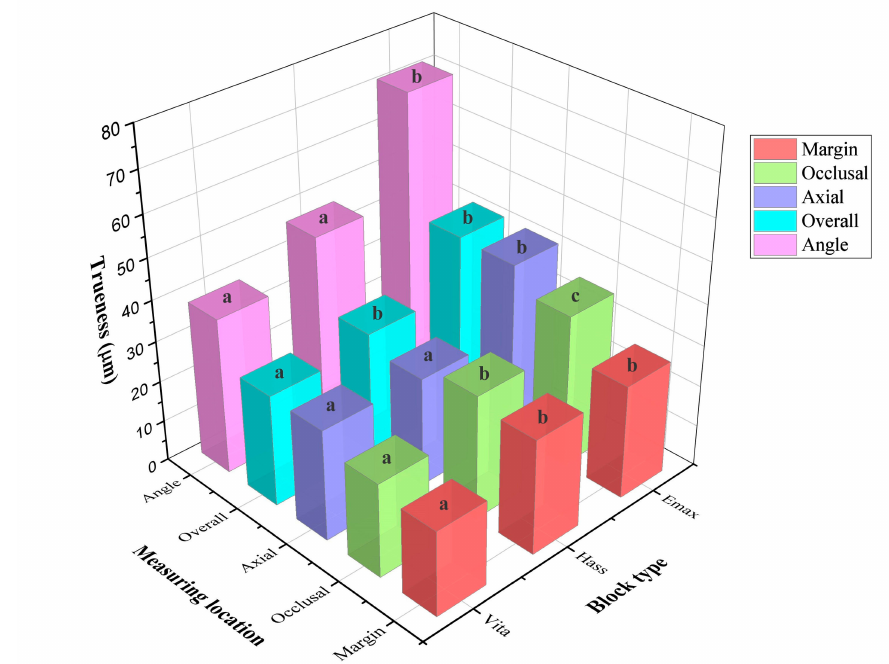
Figure 3. Comparison of RMS values for each crown inner region for di ff erent lithium disilicate